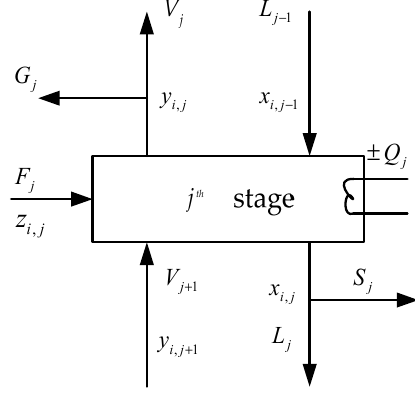
Figure 5. Scheme for the j th stage.